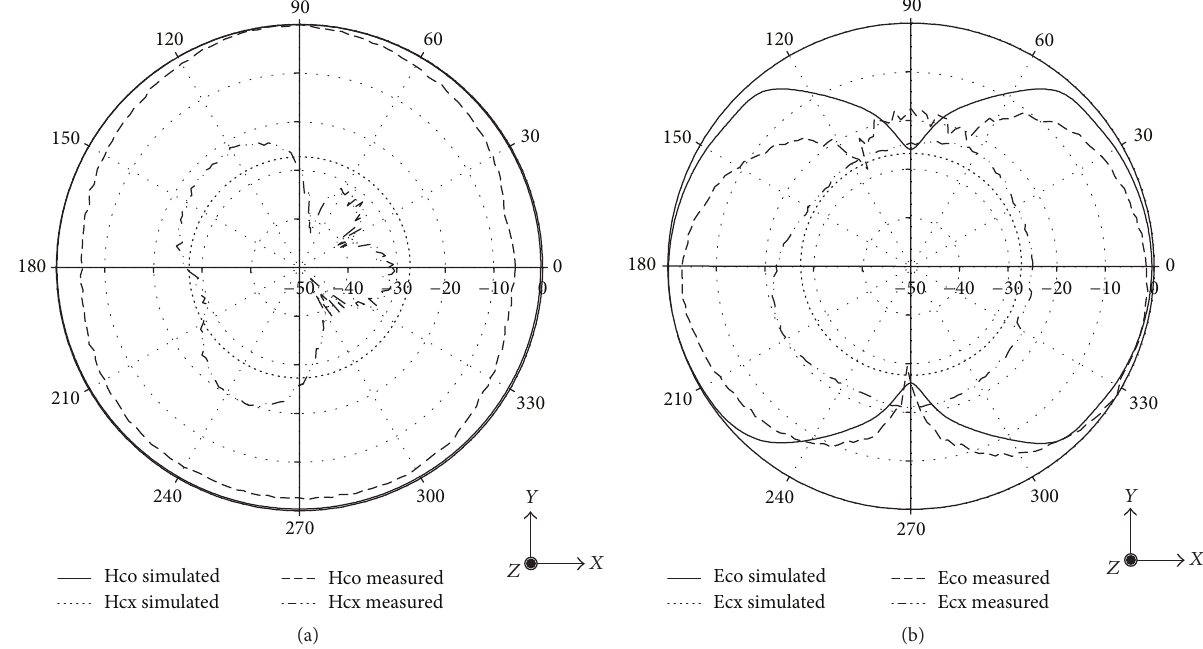
Figure 10: Measured and simulated radiation patterns of the antenna at the first band (2.4 GHz). (a) H-plane. (b) E-plane.